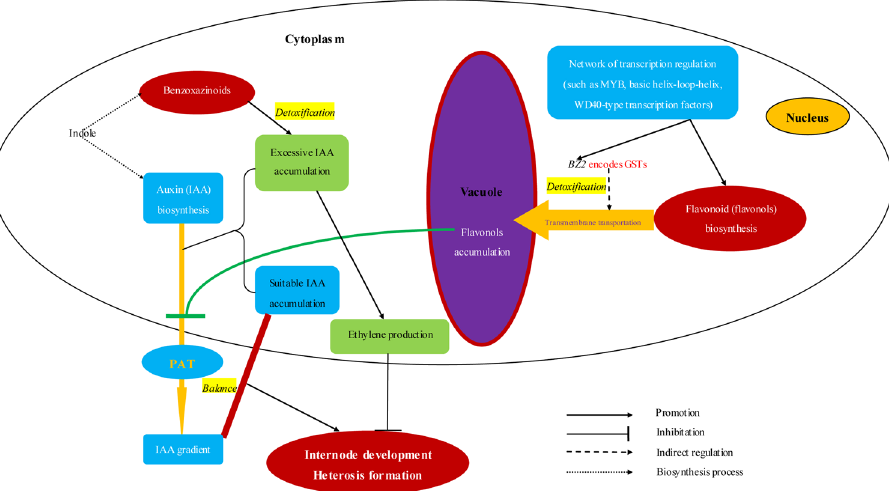
Figure 8. Model of the development and heterosis of internodes. The development and heterosis of internodes are mainly regulated by an auxin gradient, which is the result of a balance between polar auxin transport (PAT) and auxin biosynthesis. In plant cells and organs, PAT is negatively regulated by flavonols, which are biosynthesised in the cytoplasm and stored in the vacuole. Transmembrane transport of flavonols to the vacuole is indirectly regulated by structural genes (e.g., BZ2 ) encoding glutathione S-transferases. Additionally, flavonol biosynthesis and BZ2 expression are regulated by a network of transcription factors. Once PAT is inhibited, auxin will accumulate in cells and organs to toxic levels. Moreover, excessive auxin concentrations induce ethylene production, which negatively regulates plant development. Thus, detoxification by benzoxazinoid metabolites and the competition for indole between the indole-3-acetic acid biosynthesis pathway and the benzoxazinoid metabolic pathway are required to protect cells and organs. Therefore, flavonols, which are synthesised in the phenylpropanoid metabolic pathway, and benzoxazinoids are important regulators of the development and heterosis of internodes via a complex network of key structural genes and transcription